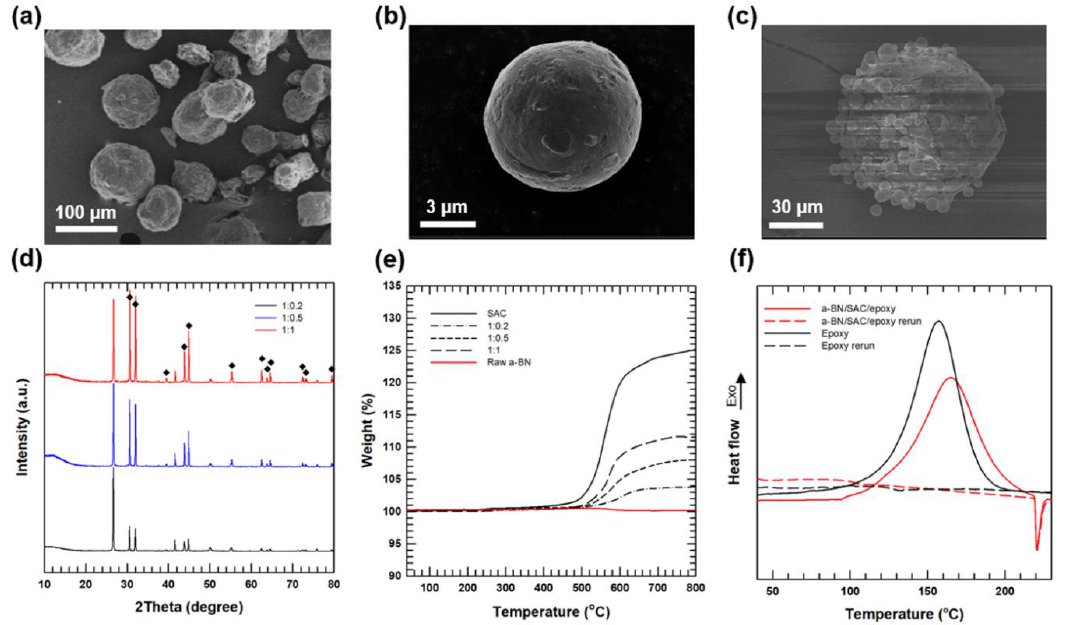
Figure 3. Field-emission scanning electron microscope (FE-SEM) images of ( a ) aggregated boron nitride (a-BN), ( b ) SAC305, and ( c ) 1:1 wt ratio of a-BN/SAC305 hybrid filler particle. ( d ) XRD pattern of the hybrid fillers with various wt ratio. ( e ) Thermogravimetric analysis (TGA) curves for raw a-BN, SAC305, and hybrid fillers with various wt ratios under air atmospheres. ( f ) In-situ differential scanning calorimetry (DSC) curves of neat epoxy resin and epoxy resin mixed with hybrid filler. The dashed lines show the curves for second heating scan.